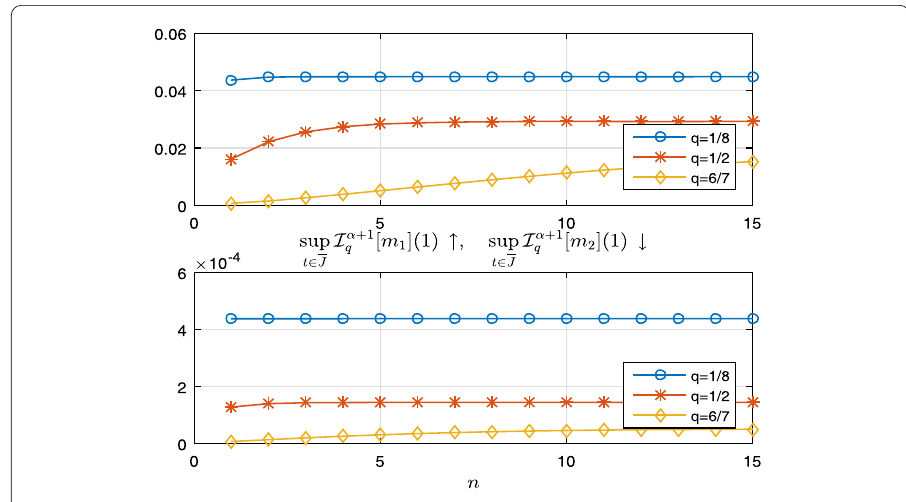
, 1 , 6 in Example 8 2 7